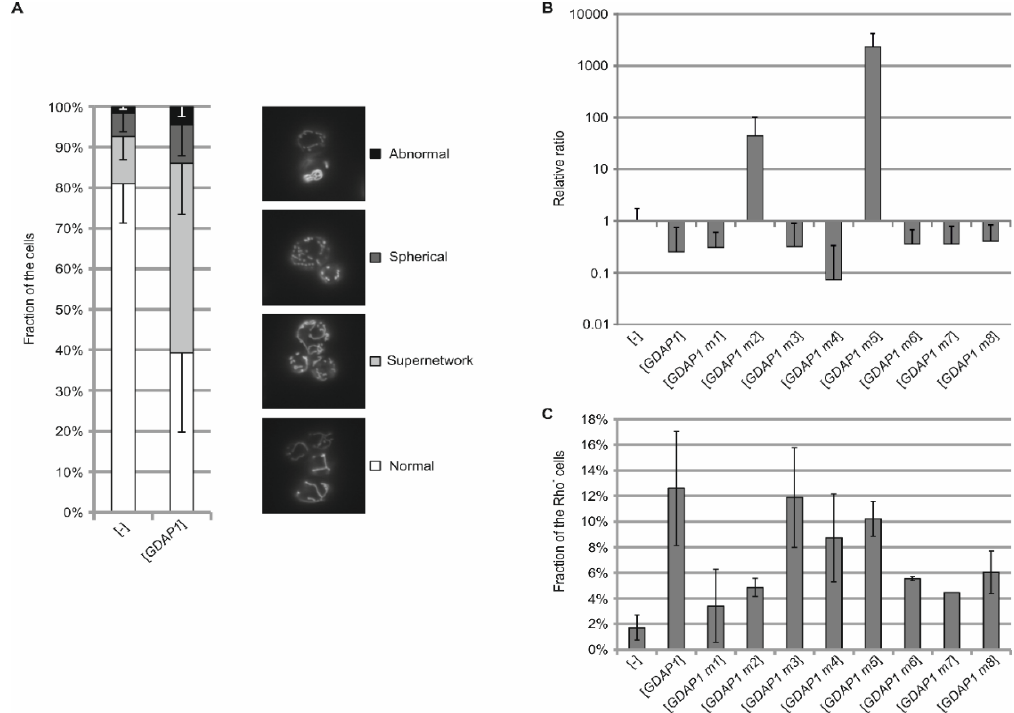
Figure 3. Mitochondria functioning is changed upon GDAP1 expression in yeast. ( A ) Overnight cultures of wild-type yeast cells harboring plasmid bearing mitochondrially targeted green fluorescent protein (mt-GFP) and empty vector ([-]) or plasmid with full-length GDAP1 were shifted to glycerol-containing medium for 4 h to induce expansion of mitochondria. Mitochondrial morphology was observed using fluorescent microscopy. The described phenotypes were counted. Error bars represent standard deviation for three independent biological experiments. ( B ) PTY44 strain transformed with empty vector ([-]) or GDAP1 gene variants (as indicated) was incubated for 2 days in glycerol-containing medium and then the cells were counted, and dilutions of every culture were plated on YPD or SC-trp medium. After 3 d of incubation at 28 ◦ C the number of colony-forming units (CFUs) was calculated. The fraction of SC-trp-growing cells in every culture were normalized to PTY44 with empty vector ([-]). Error bars represent standard deviation for four experiments. ( C ) Wild-type yeast strain harboring empty vectors ([-]) or plasmids with GDAP1 alleles were grown overnight in SC gly-leu medium. The cultures were diluted, and cells were plated on YPG + 0.2% glucose and incubated for 3 d at 28 ◦ C. CFUs were counted and the percentage of small colonies was calculated. Error bars represent standard deviation for four experiments.